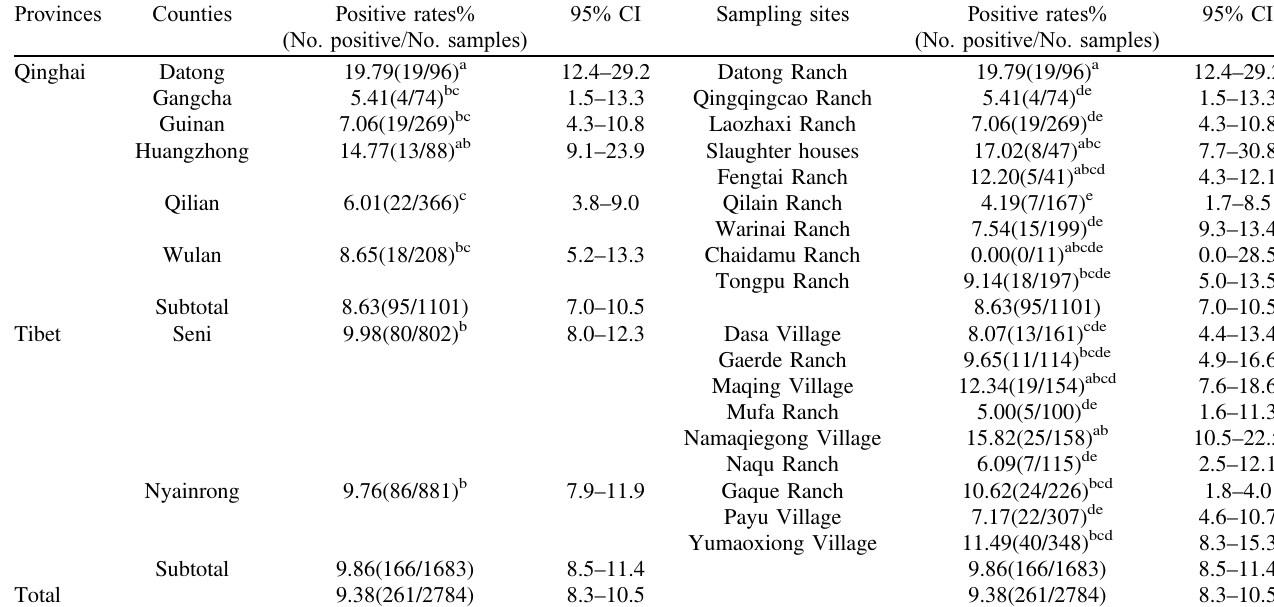
Table 1. Prevalence of T. gondii in yaks in different provinces, counties and sampling sites on the Qinghai-Tibetan Plateau.